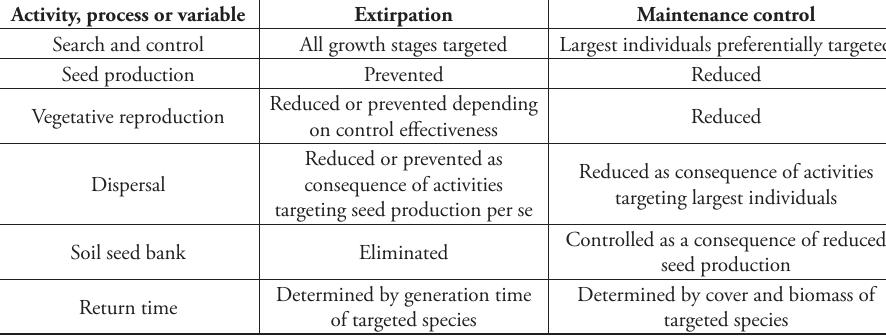
Table 1. Tactics for extirpation versus maintenance control. Widespread invaders are generally not good candidates for extirpation because of a continued risk of re-invasion. In the context of asset protection the intensity of control required to keep the invader at maintenance levels will be significantly less than would be the case if the management goal were